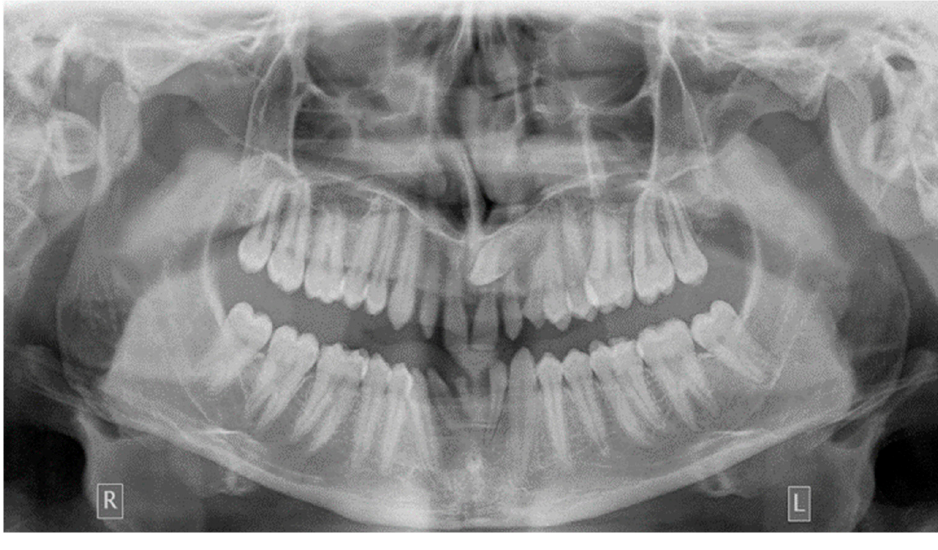
Figure 2. Impacted first mandibular molars.